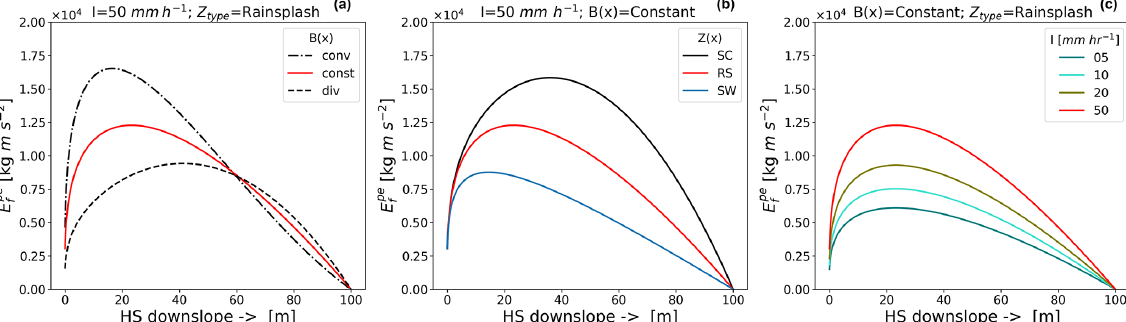
per unit length (Jm − 1 ) as a function of (a) hillslope width, (b) geopotential distribution (form) f